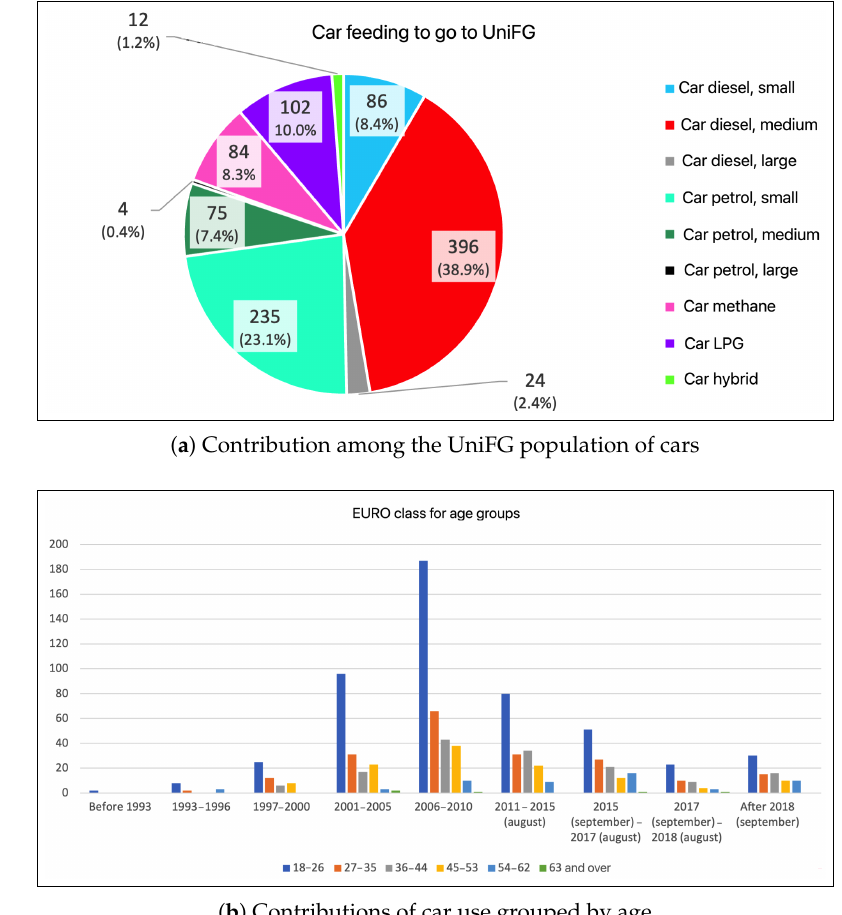
Figure 16. Contributions of cars.